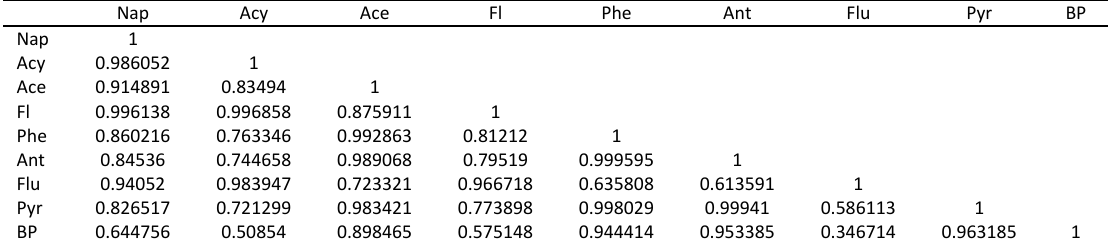
Table 3: Pearson correlation coefficient of non-carcinogenic PAHs